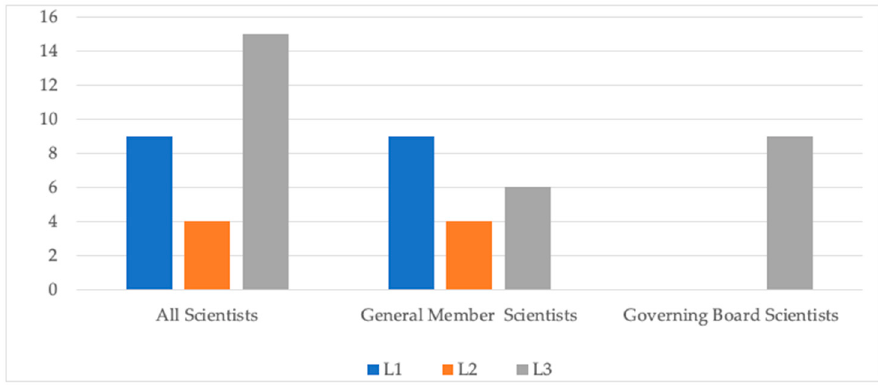
Figure 2. Level of engagement for general member scientists, governing board scientists, & all scientists (combined).